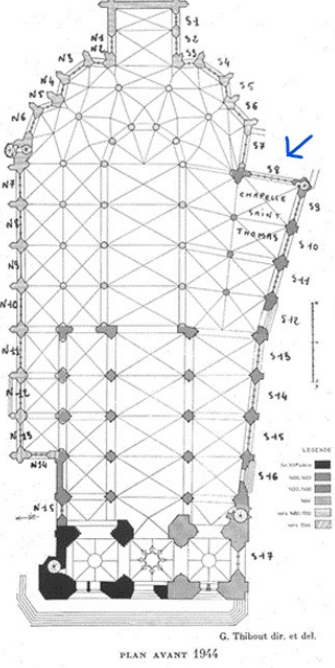
Figure 4. Saint-Lô, Church of Notre-Dame, plan showing location of the former Saint George chapel, rededicated to Saint Thomas in 1811. The Saint Thomas window appears above the altar and is identified as S8 on the plan. Photo: G. Thibout (image in the public domain).